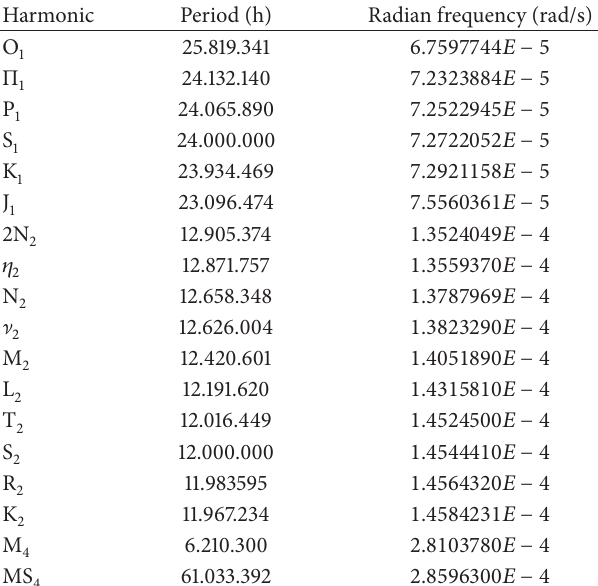
Table 1: Main astronomic tide components, periods, and radian frequencies (table from